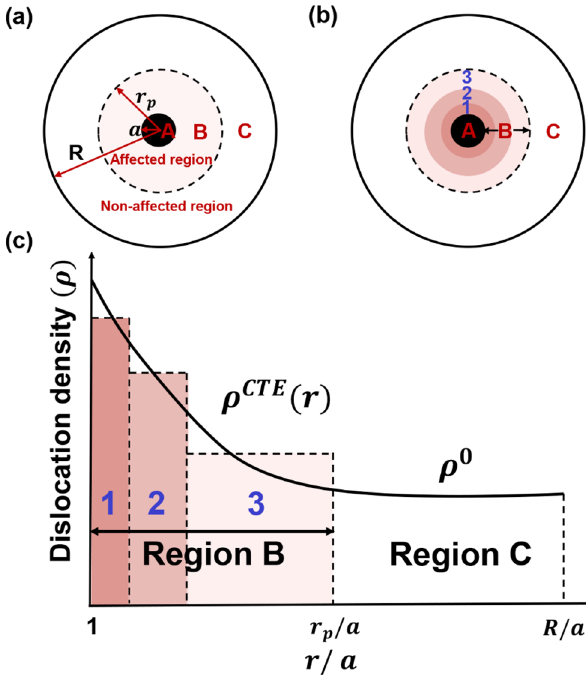
Figure 3. Schematic diagram of thermal mismatch induced dislocations in the TMDT model. ( a ) A representative grain with three regions: spherical particle reinforcement (region A), plastic accommodating region (region B), and non-affected region (region C). ( b ) Region B is further divided into three subregions considering gradient dislocation density distribution. ( c ) ρ CTE ( r ) in region B, showing dislocation density 0 variation with the distance ( r ) that away from the interface, and ρ is the initial average dislocation density in region